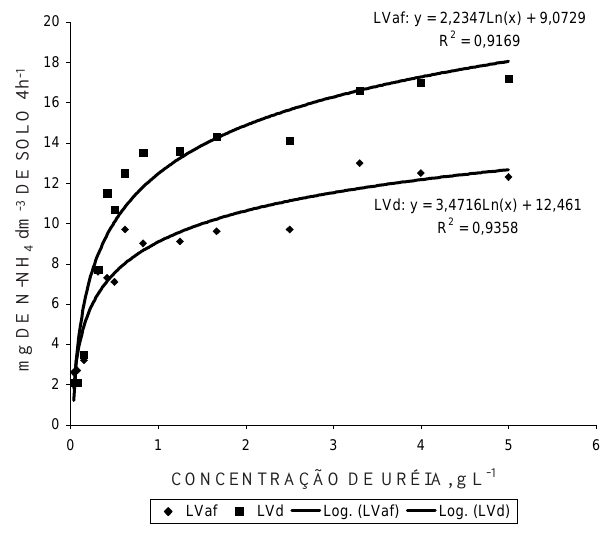
Figura 5. Velocidade de hidrólise da uréia (mg de dm -3 de solo 4 h -1 ) sob diferentes N-HH 4 concentrações de substrato, em amostras de Latossolo Vermelho Aluminoférrico típico e Latossolo Vermelho distrófico